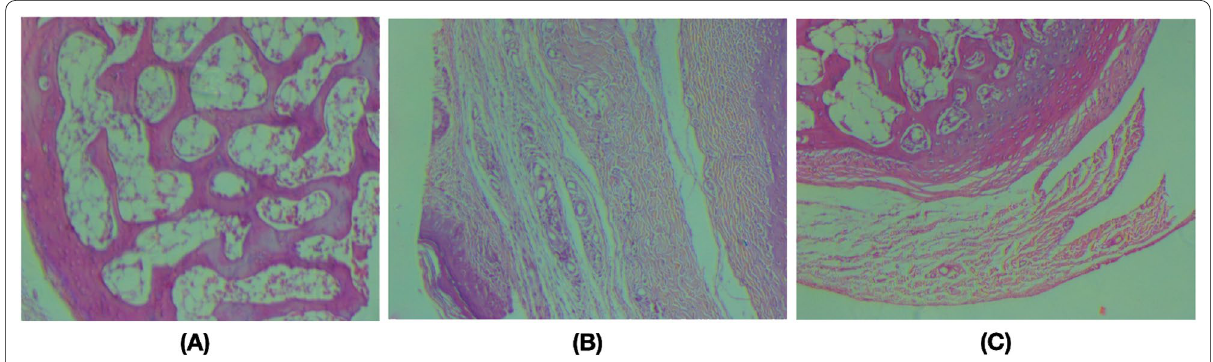
Fig. 10 Histopathological slides of knee joint after treatment with VMS A Disease control B Test group C Reference